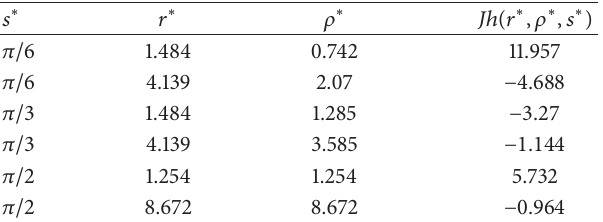
Table 2: The values of solution 𝑠 ∗ , 𝑟 ∗ , 𝜌 ∗ and the Jacobian 𝐽ℎ(𝑟 ∗ , 𝜌 ∗ ,𝑠 ∗ )